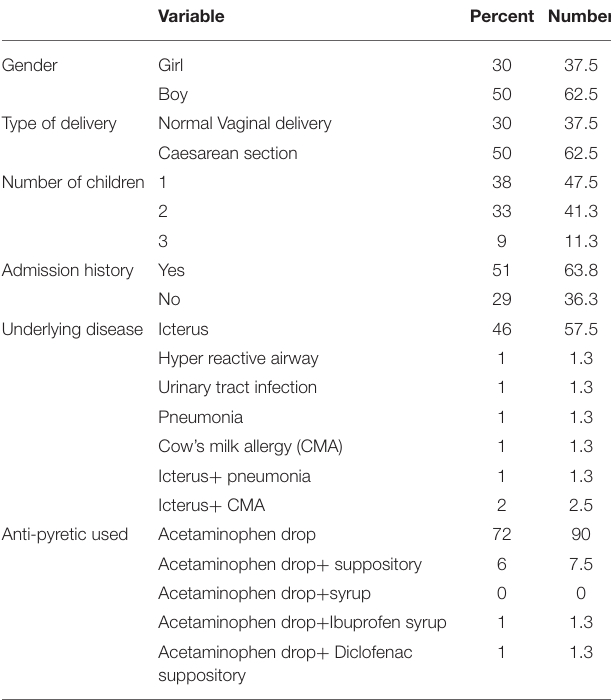
TABLE 1 | Demographic information of the participants.